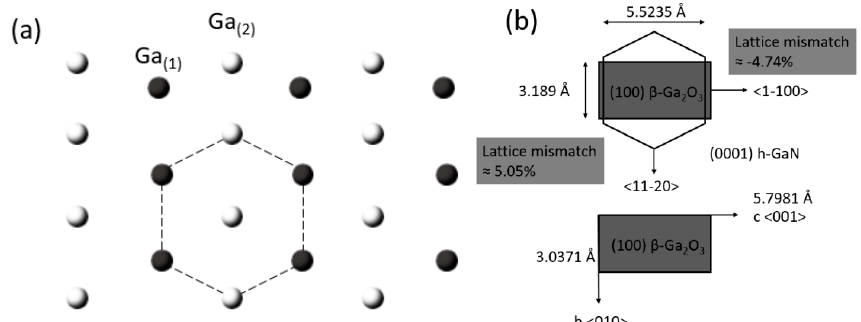
Figure 4. ( a ) Projection of β -Ga 2 O 3 atomic structure perpendicular to the a -plane, showing the hexagonal-like arrangement of the Ga atoms bonded to O (3) , and ( b ) schematic illustration for the epitaxial relationship between c -plane h-GaN and a -plane β -Ga 2 O 3 . However, such an anisotropic stress state (tensile stress parallel to the c -axis and compressive one parallel to the b -axis) was considered to be of little possibility. Víllora et al. presented that there was a deviation angle of 1° calculated by image asymmetry of an electron-diffraction pattern. The